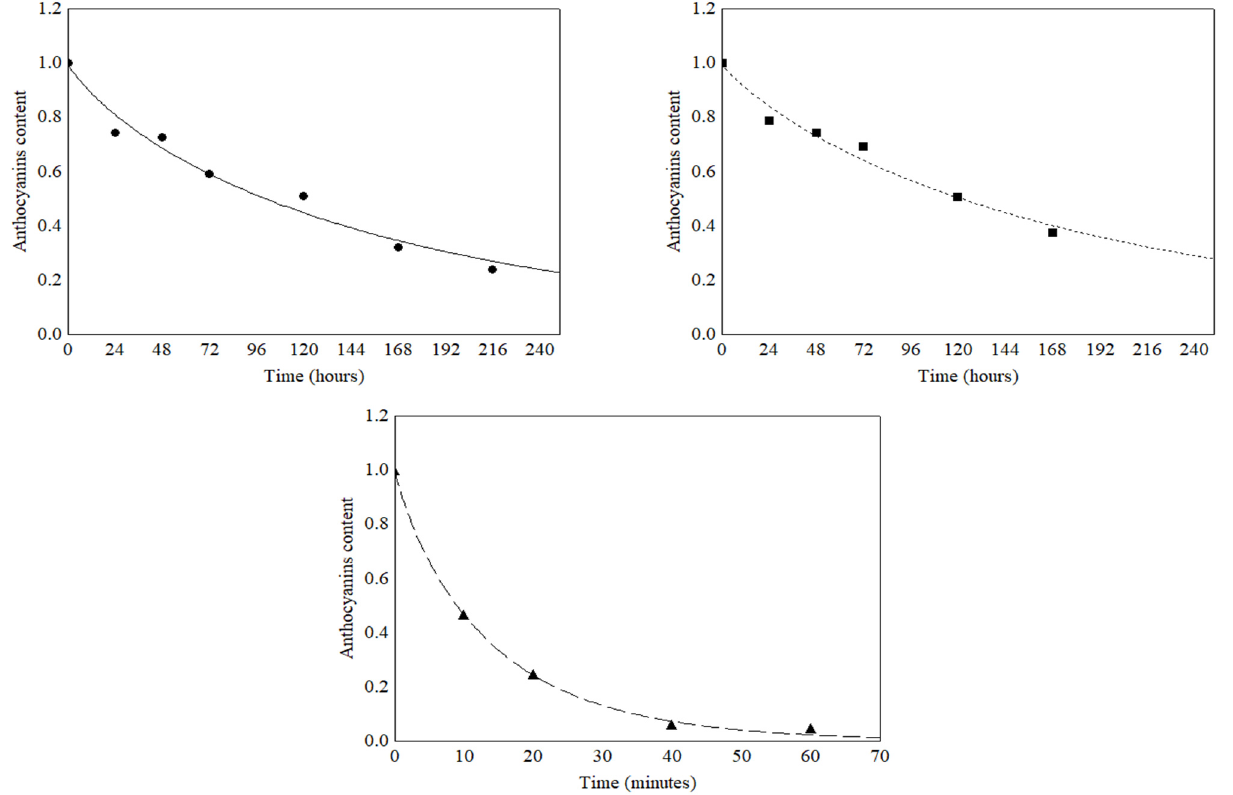
Figure 3. Weibull model fitted to the light degradation data of anthocyanins in grumixama extracts. ( ) Fluorescent, ( ) Incandescent and ( ▲ ) Ultraviolet lights. Table 5. Parameters of mathematical modeling and kinetic parameters of light degradation of anthocyanins in grumixama extracts obtained by the Weibull model.